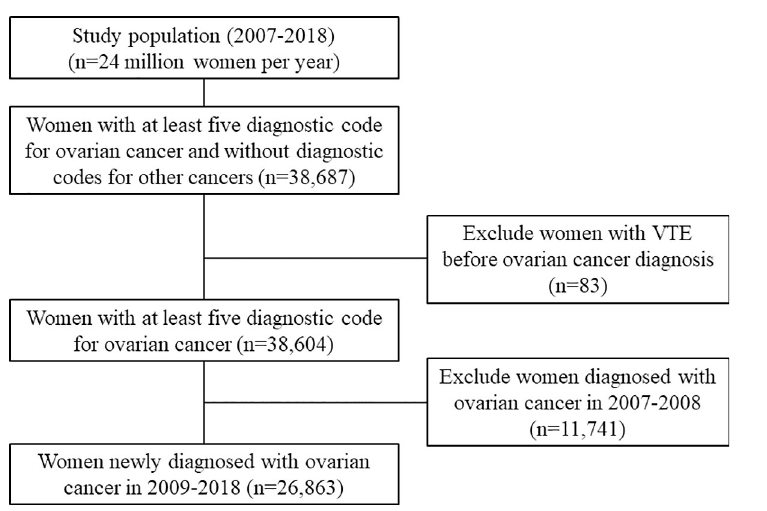
Fig 1. Flow chart showing selection of eligible